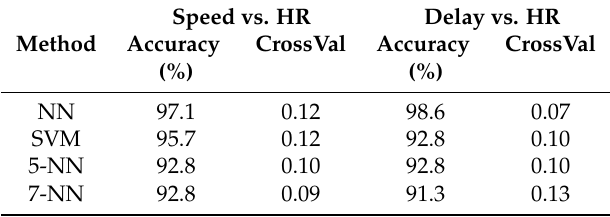
Table 3. Comparison of accuracy and cross-validation for classification of two cycling features